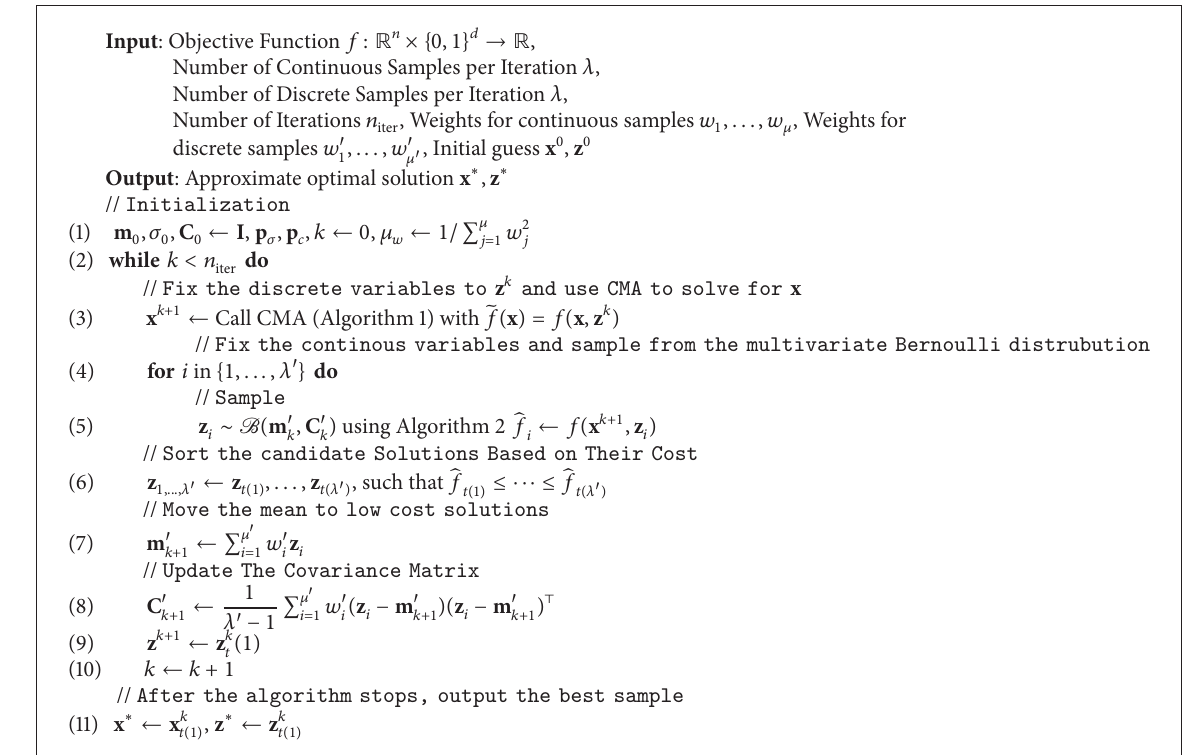
Algorithm 3: Covariance Matrix Adaptation with Mixed Variables (CMA-MV).